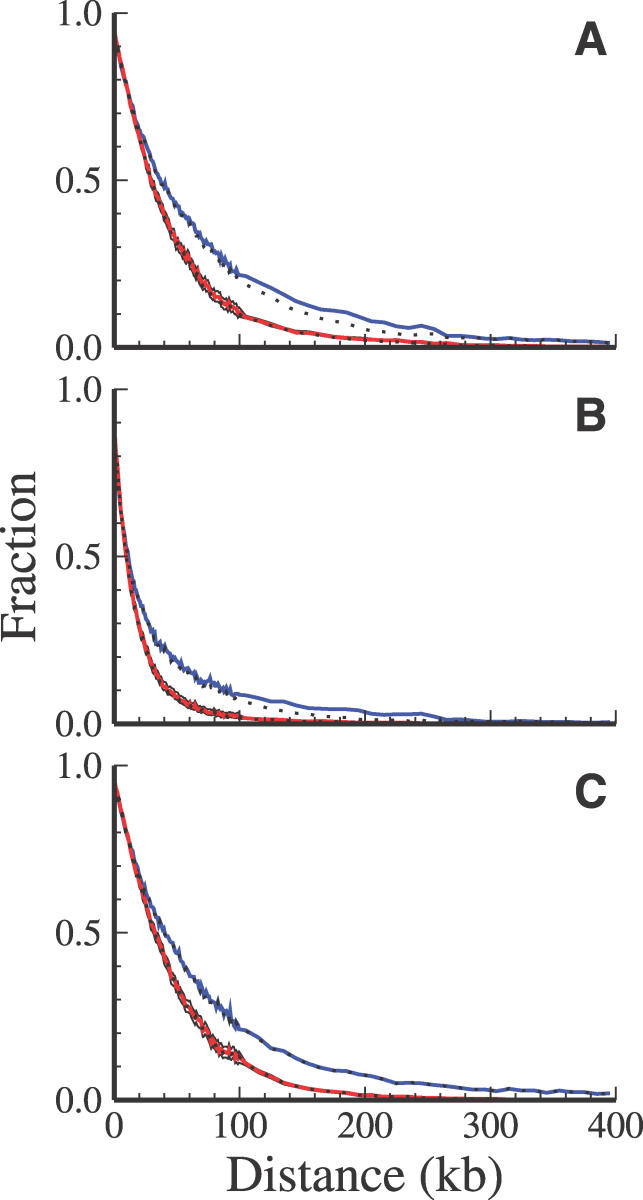
Fraction of SNP Pairs—with Identical Numbers of Minor Allele Observations—in Perfect LD for Intergenic and Genic RegionsThe dashed lines show the results after removing the 100 regions that contribute the most perfectly correlated SNP pairs for the European (A), African-American (B), and Han Chinese (C) populations.